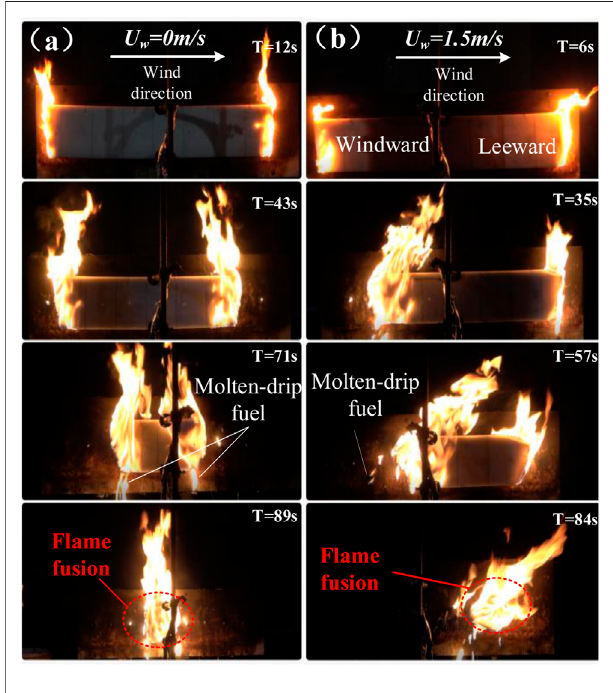
FIGURE 2 | Melting-dripping and fusion behavior of adverse fi re spreading of the adherent FPU at U w (cid:1) 0 m / s (A) and U w (cid:1) 1.5 m / s (B)